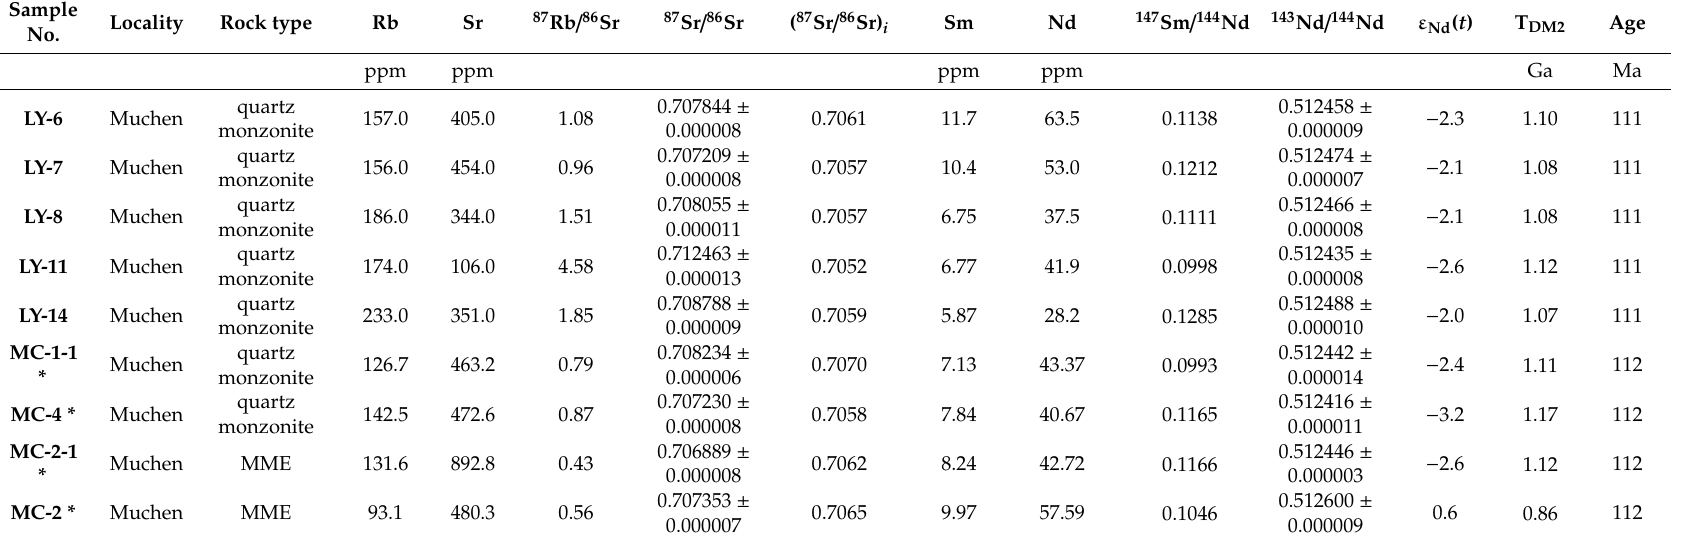
Table 3. Rb-Sr and Sm-Nd Isotopic Data for Muchen